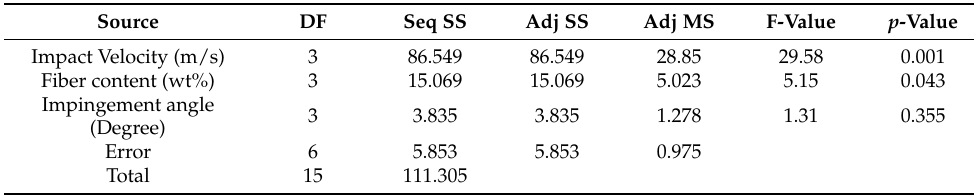
Table 10. Analysis of variance for SNRA2, using adjusted SS for tests